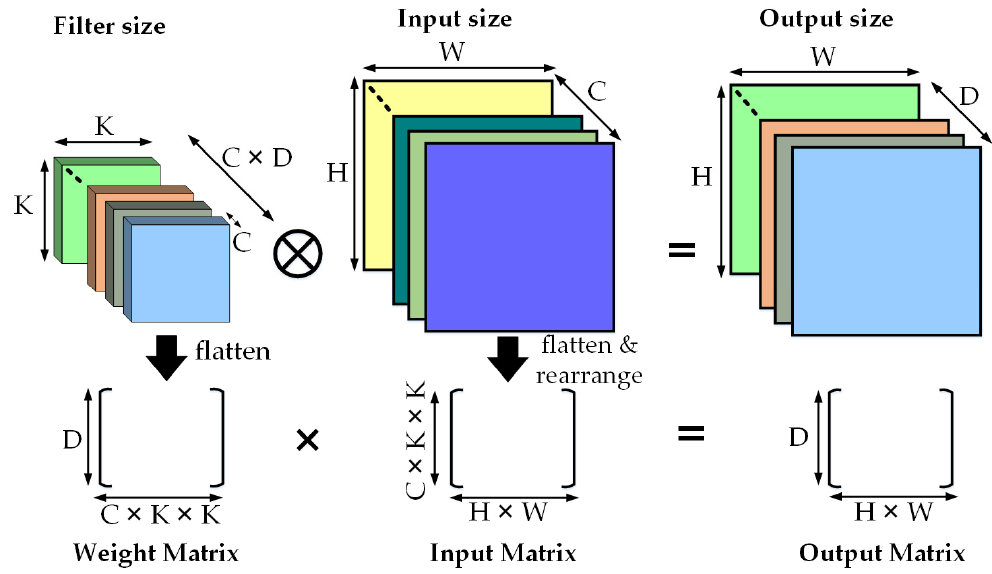
Figure 10. Mapping of convolution (Conv) layers onto matrix multiplication.